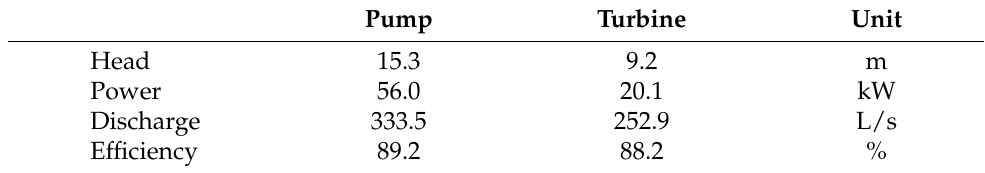
Table 1. Engineering quantities at the design point in pump and turbine